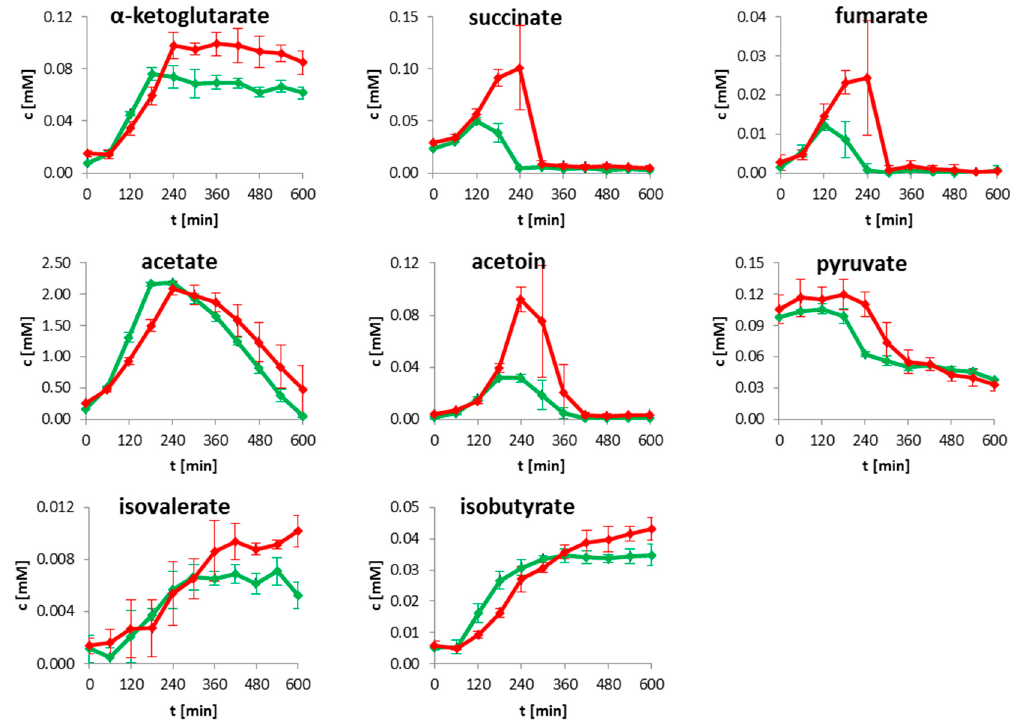
Figure 1. Time resolved quantification of selected metabolites for wild type (green) and clpP mutant (red). The growth curve for wild type (black) and mutant (grey) are illustrated together with the intracellular sampling time points (black and grey arrows) on the left side. Data are shown for four biological replicates.